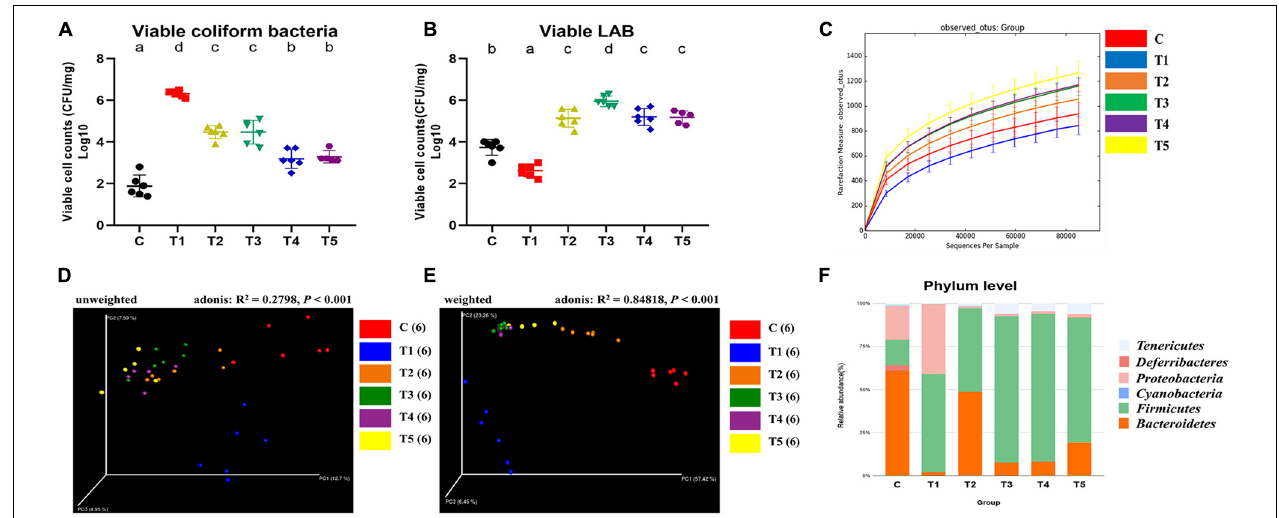
FIGURE 3 | Effects of pro-/synbiotics on the gut microbiota of murine dysbiosis model with pathogen Escherichia coli infection. The viable cell counts of coliform bacteria (A) and LAB (B) were enumerated by plating 10-fold serially diluted intestinal contents (original concentration: 10 mg intestinal contents/1 ml PBS) onto MacConkey agar and MRS agar, respectively. QIIME version 1.9.1 software was used to investigate alpha diversity indices such as microbial richness (observed OTUs) per group (C) , PCoA plot based on unweighted (D) , and weighted (E) UniFrac distances, and the overall compositions of the gut microbiota at the